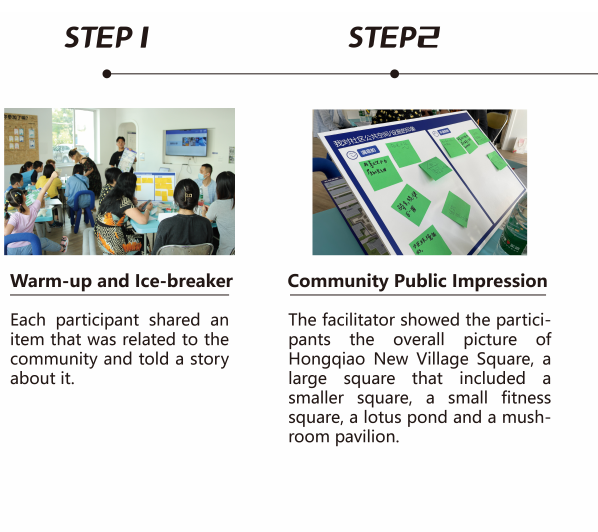
Figure 3 Figure 3. Co-creation workshop toolkits.